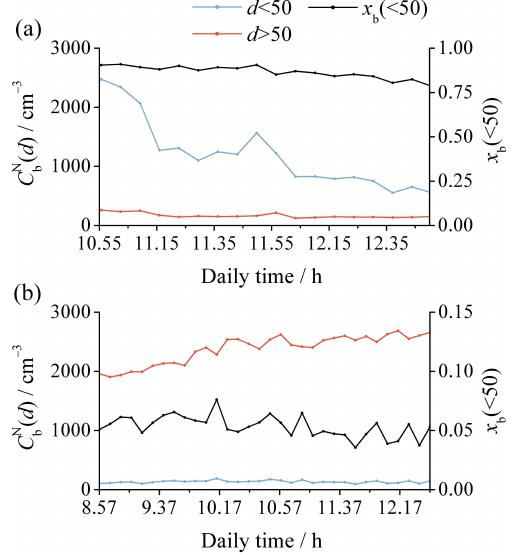
(d) ) of background b ( < 50)) and bigger than b